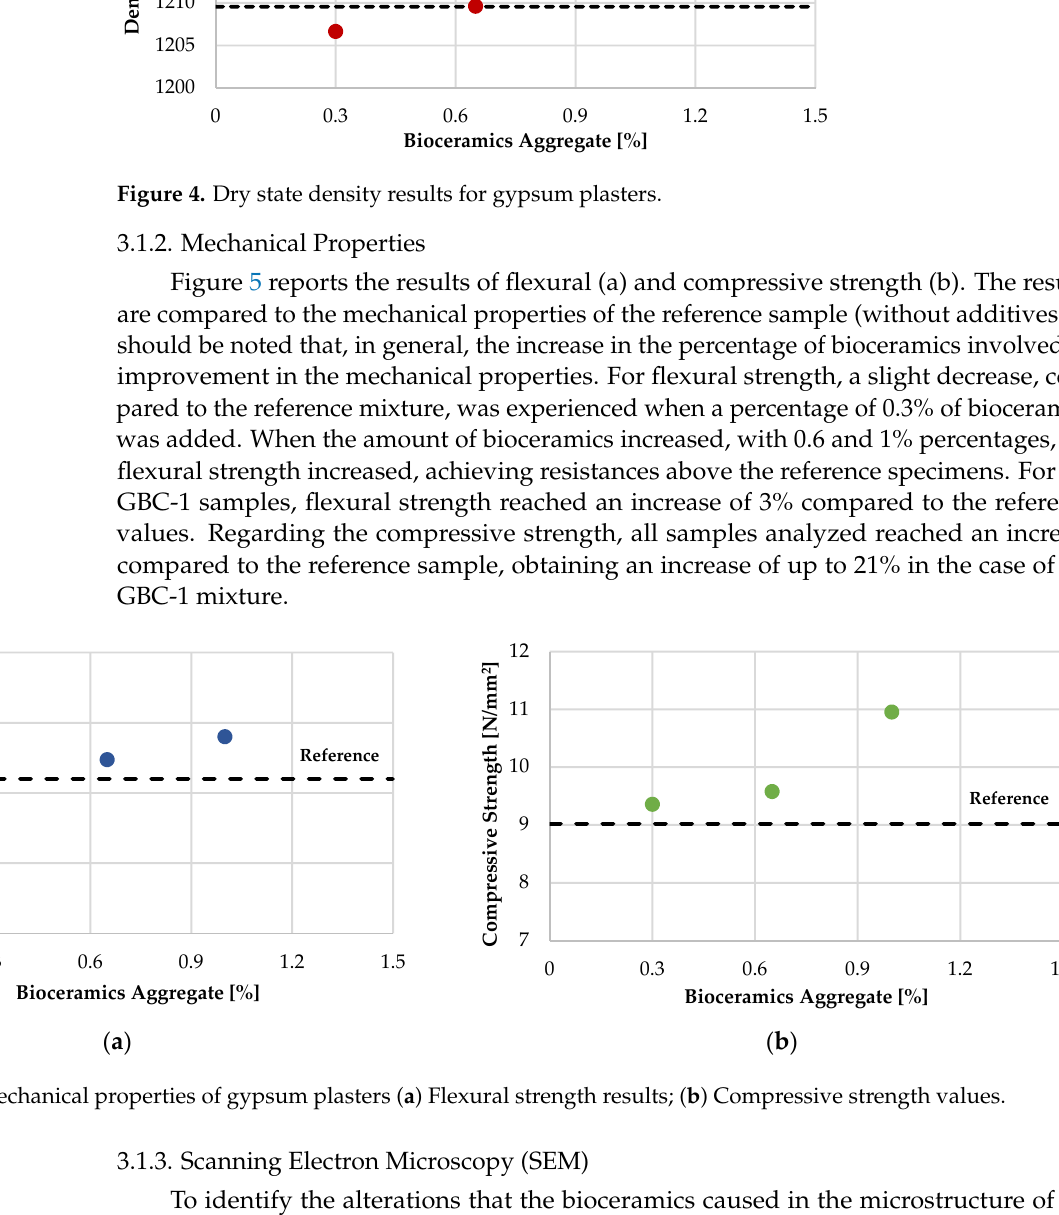
Figure 4. Dry state density results for gypsum plasters.